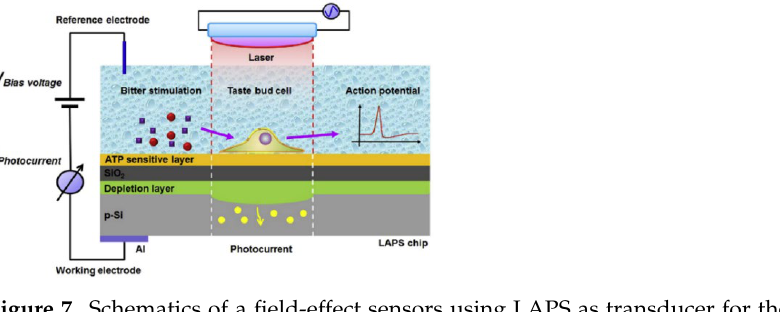
Figure 7. Schematics of a field-effect sensors using LAPS as transducer for the detection of ATP release and membrane potential changes from single taste bud cell. (Reprinted with permission from ref. [90]. Copyright 2018 Elsevier).